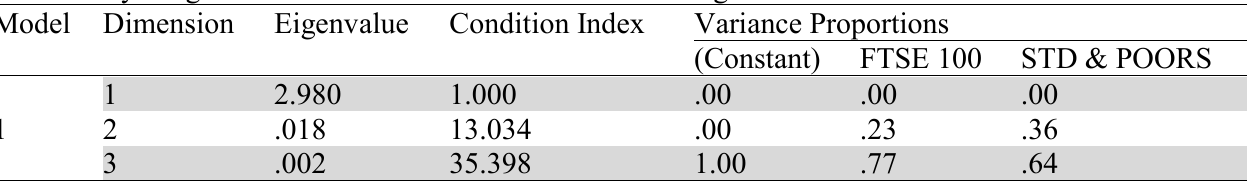
Collinearity Diagnostics on the Influence of Financial Contagion and Performance of NSE 20 Share Index Model Dimension Eigenvalue Condition Index Variance Proportions